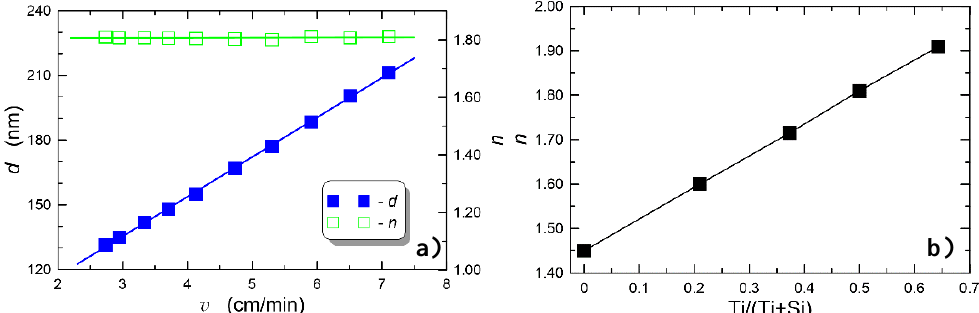
Figure 2. Dependence of WG film thickness and refractive index on withdrawal speed of the substrate from the sol ( a ), and the dependence of refractive index on the stoichiometric ratio between Si and Ti components in the sol ( b ).